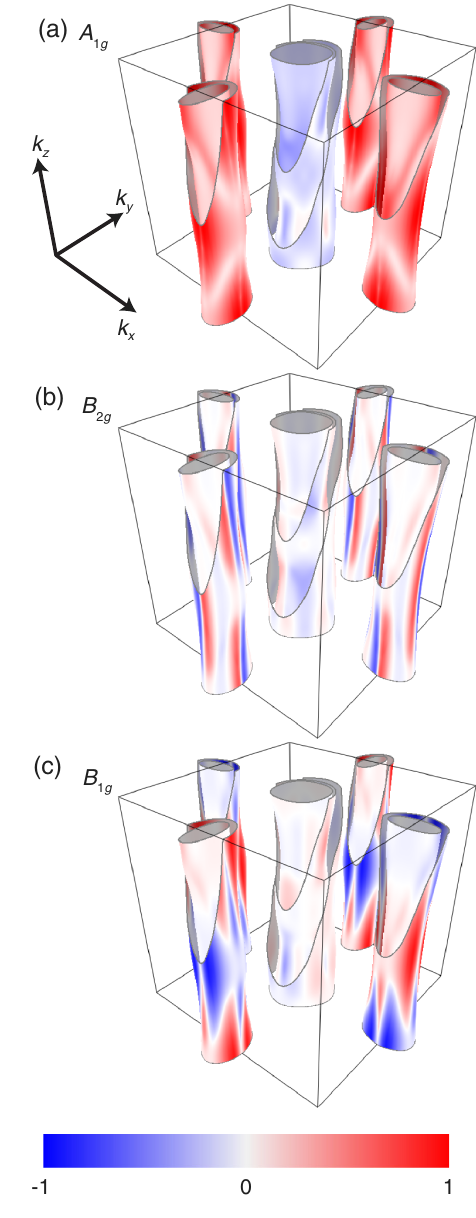
FIG. 2. Raman vertices in (a) A 1 , (b) B 2 , and (c) B 1 symmetry g g g at the Fermi energy E . The black frame represents the 1 Fe BZ F ranging from − π to π in each dimension k , k , and k . There are x y z three Fermi surfaces in the center and two at each face (the outer ones are cut open to visualize the inner ones) showing the hole bands and electron bands, respectively. All three symmetries have a common color scale that shows the sign and intensity of the Raman vertex at the Fermi surface. The hole bands around the BZ edges are equivalent to those in the center and are omitted for ð k Þj and the angled brackets denote an where Ω > j 2 Δ n